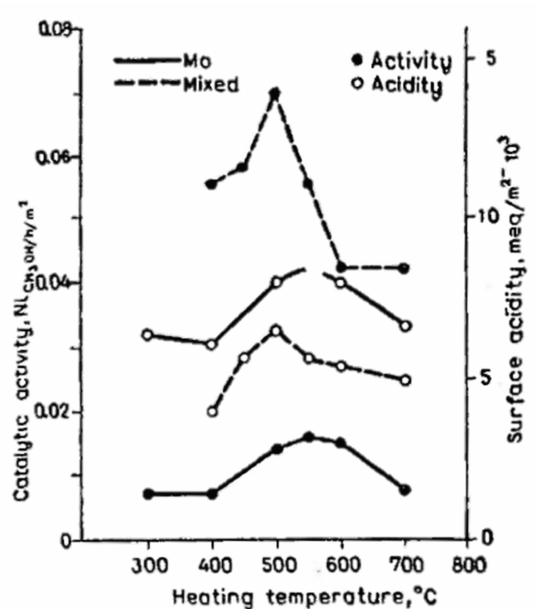
Figure 4. Catalytic activity in a differential reactor and surface acidity of pure MoO 3 and mixed 2.5: 1 MoO 3 -Fe 2 (MoO 4 ) 3 catalysts versus calcination temperature [44]. Reproduced from [44] copyright (1968) with permission from copyright holder.